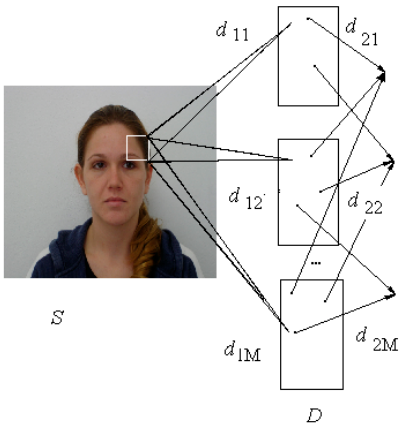
Figure 6. D layer structure.